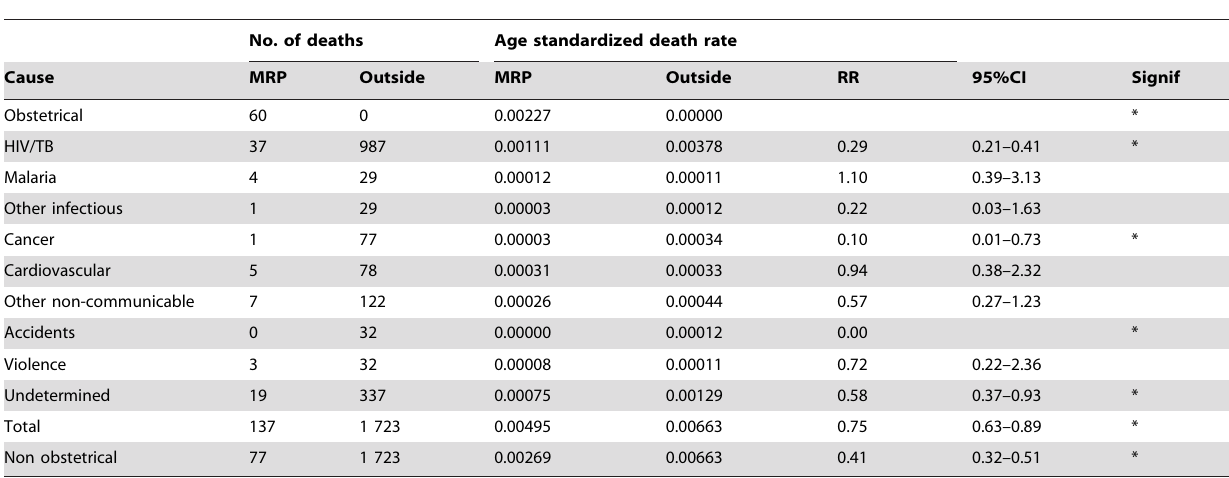
Table 2. Age standardized death rates and relative risk from selected causes, Agincourt, South Africa,